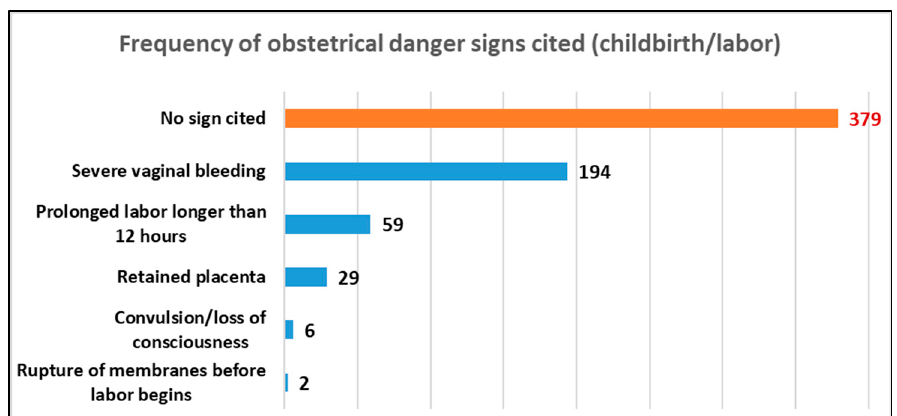
Figure 2. Frequency of ODS cited during peripartum (childbirth/labor).